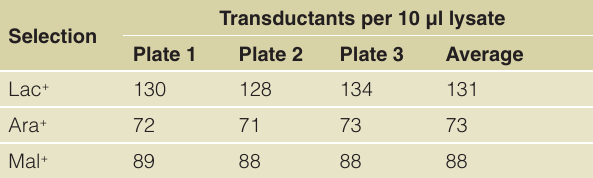
Table 1. Transduction in enterohemorrhagic Escherichia coli .